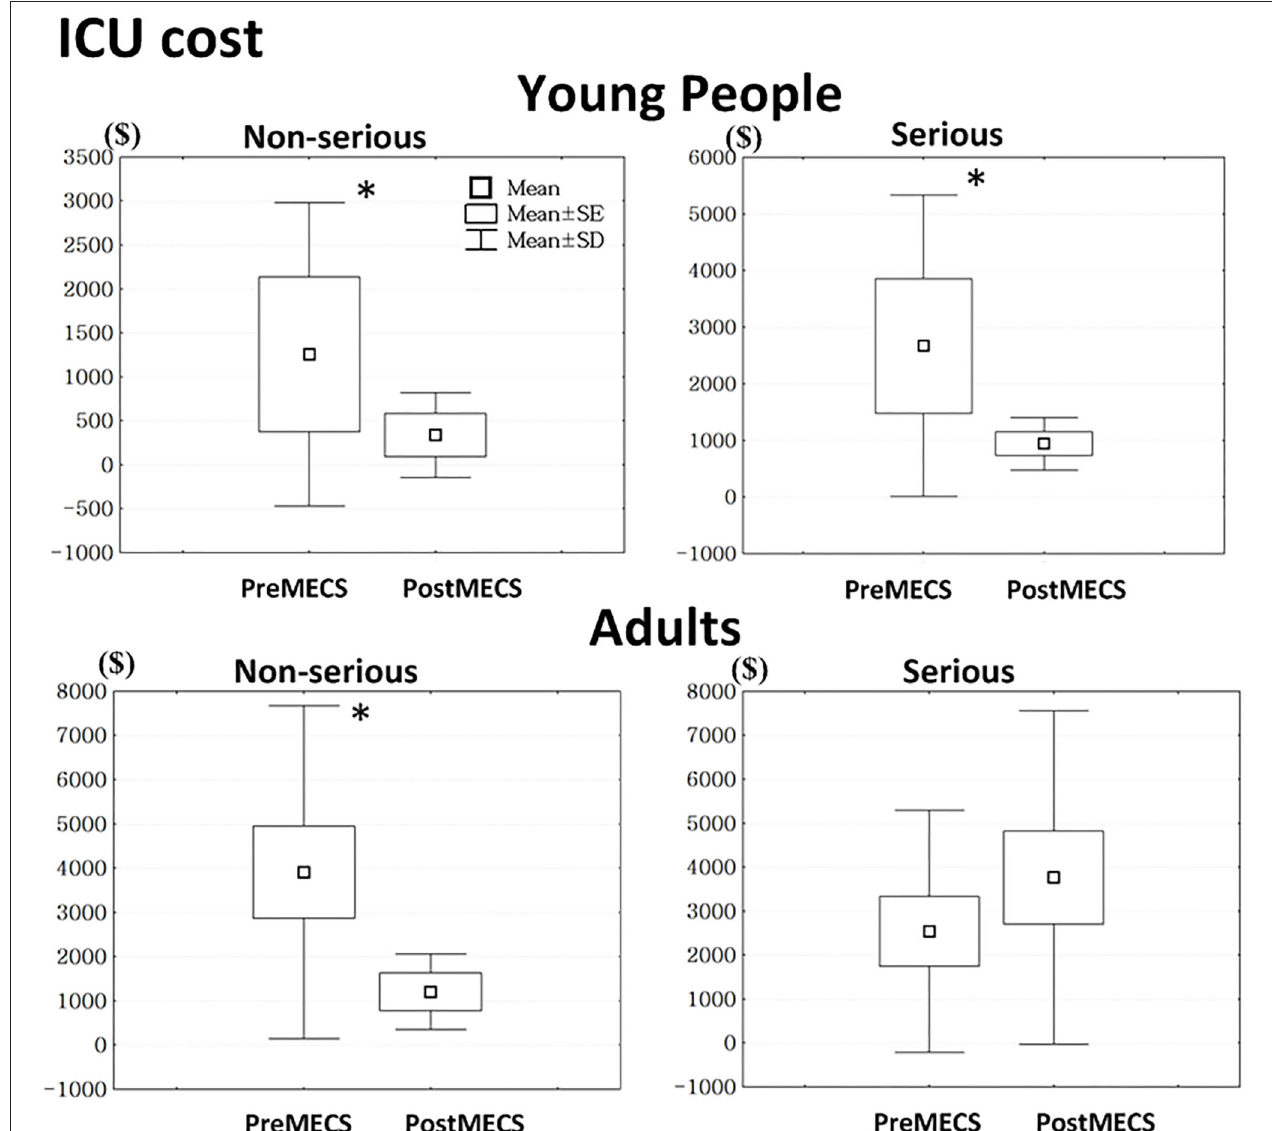
FIGURE 1 | We defined suicide attempts as being serious when showing both high intentionality and high lethality. Otherwise, we defined suicide attempts as non-serious. *Statistically significant, p < 0.05. ICU, intensive care unit; MECS, multi-disciplinary emergency consultation